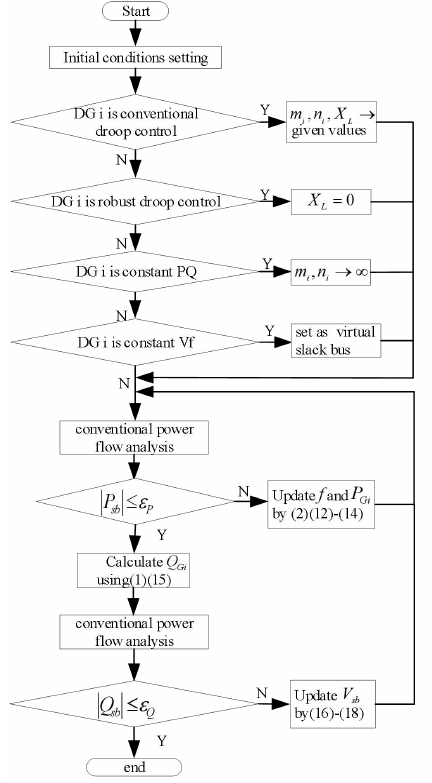
Figure 4. Flowchart of the proposed